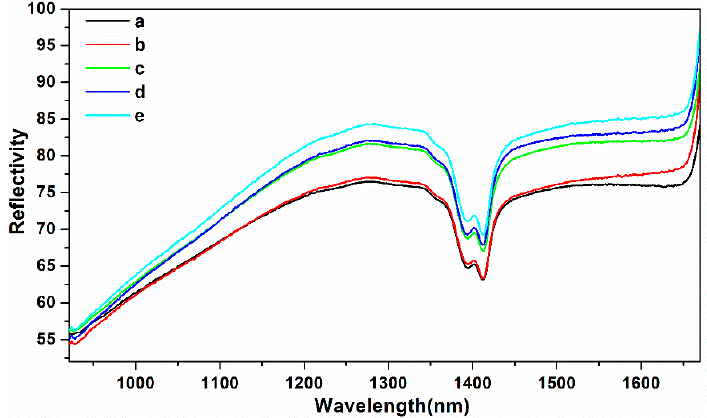
Figure 7. The average spectra of different soil particle sizes: ( a ) 1–2 mm; ( b ) 0.45–1 mm; ( c ) 0.28–0.45 mm; ( d ) 0.18–0.28 mm; ( e ) 0–0.18 mm.